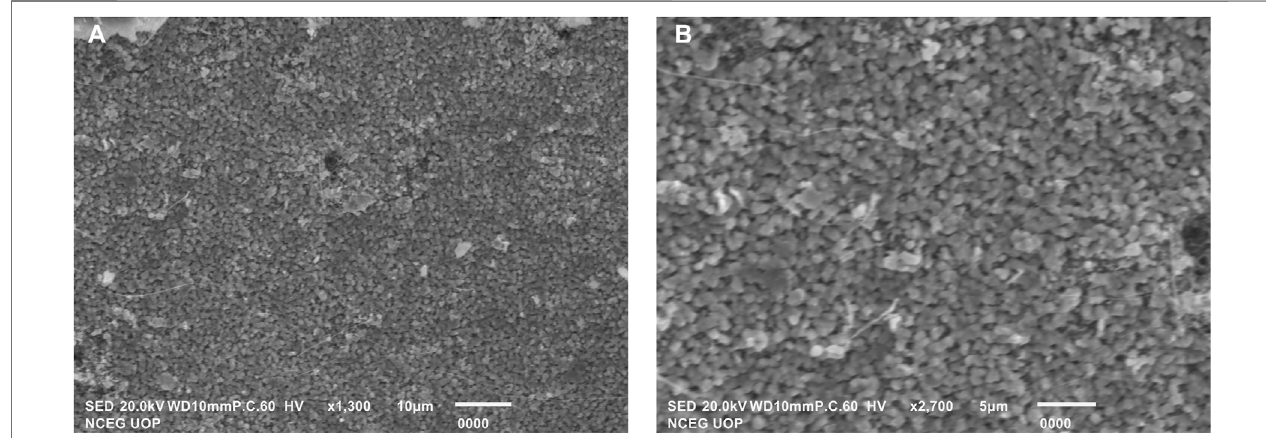
FIGURE 5 | SEM images (A) and (B) spherical shape of biosynthesized TpAgNPs.